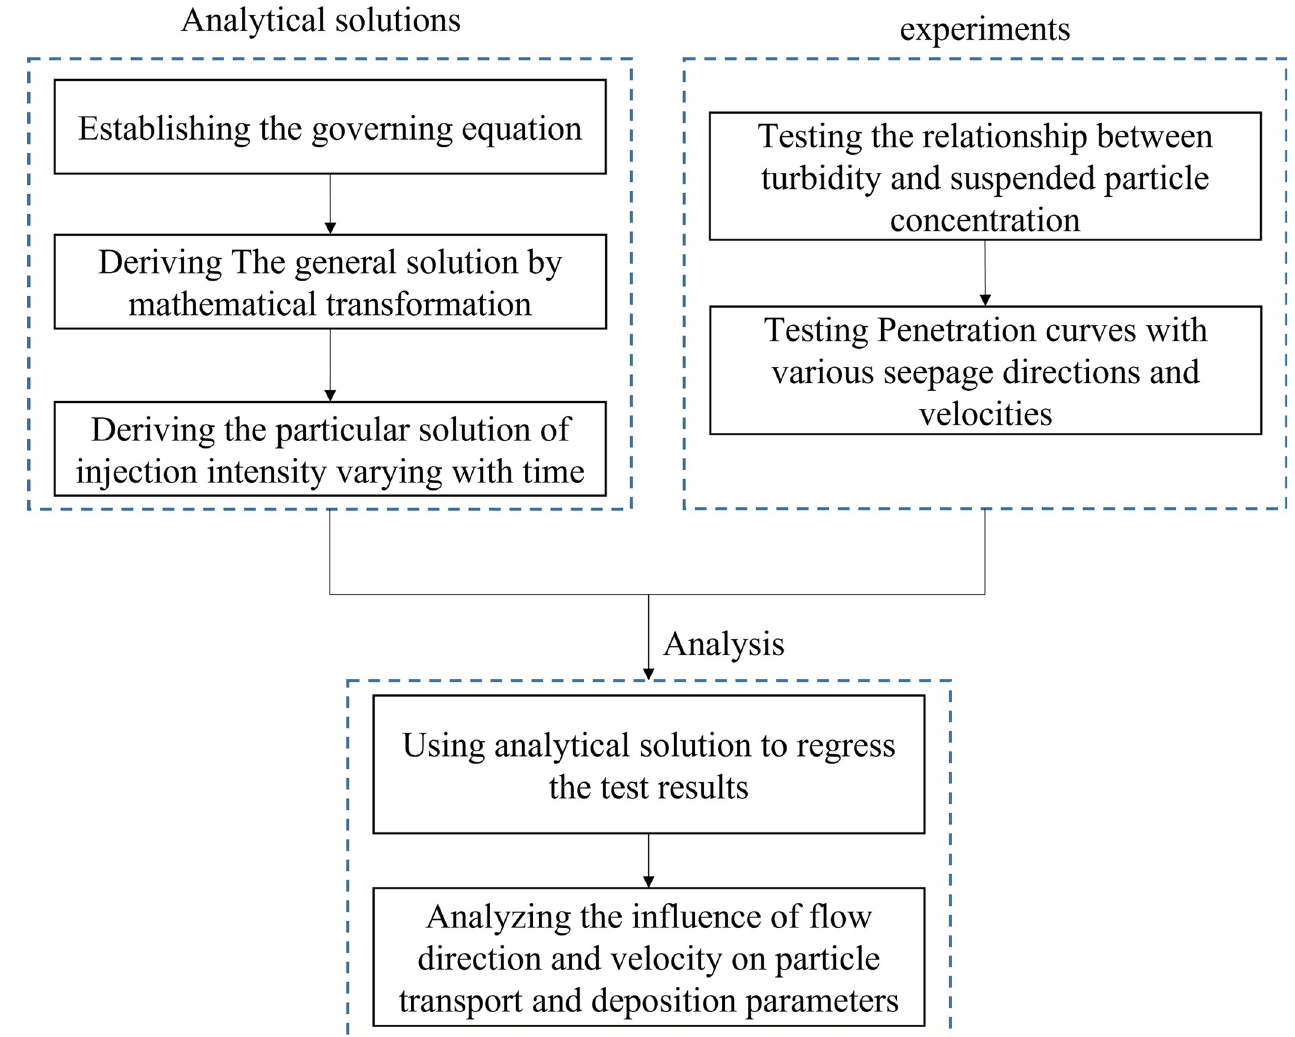
Fig 2. Flowchart of the steps of the